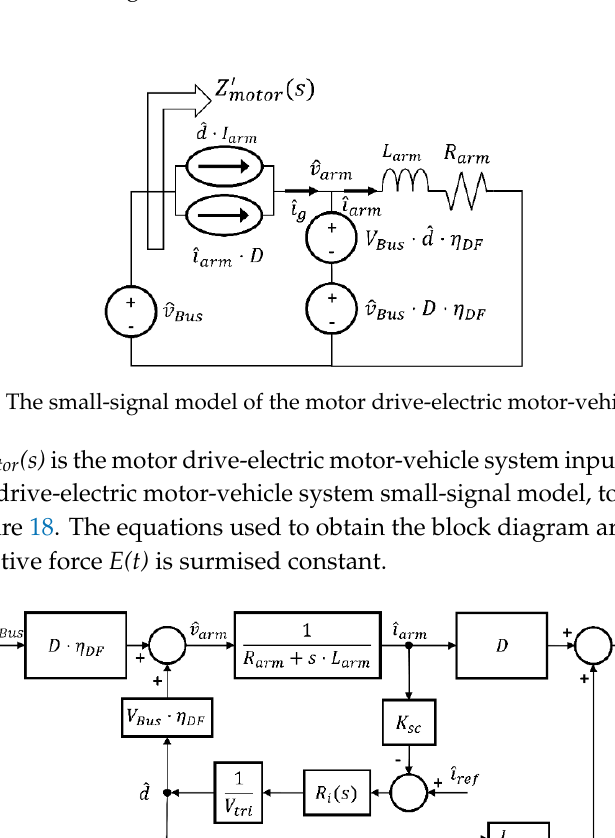
Figure 19. Simplified block diagram of the motor drive-electric motor-vehicle system with the inner control loop and without current reference signal variation. As the goal is to obtain the transfer function that relates the current that goes through the rotor i arm , the duty cycle d , and bus voltage v Bus , the blocks diagram shown in Figure 20 can be considered. Figure 20. Modified block diagram of the motor drive-electric motor-vehicle system with the inner control loop. The two diagrams placed on the left side in Figure 20 are named Giv(s) and Gdv(s) . Their transfer functions appear in (51) and (52). They are obtained from the blocks diagram in Figure 19. 𝐺𝑖𝑣(𝑠) = 𝚤̂ (cid:3028)(cid:3045)(cid:3040) 𝑣(cid:3548) (cid:3029)(cid:3048)(cid:3046) = 𝜂 (cid:3005)(cid:3007) · 𝐷 ·